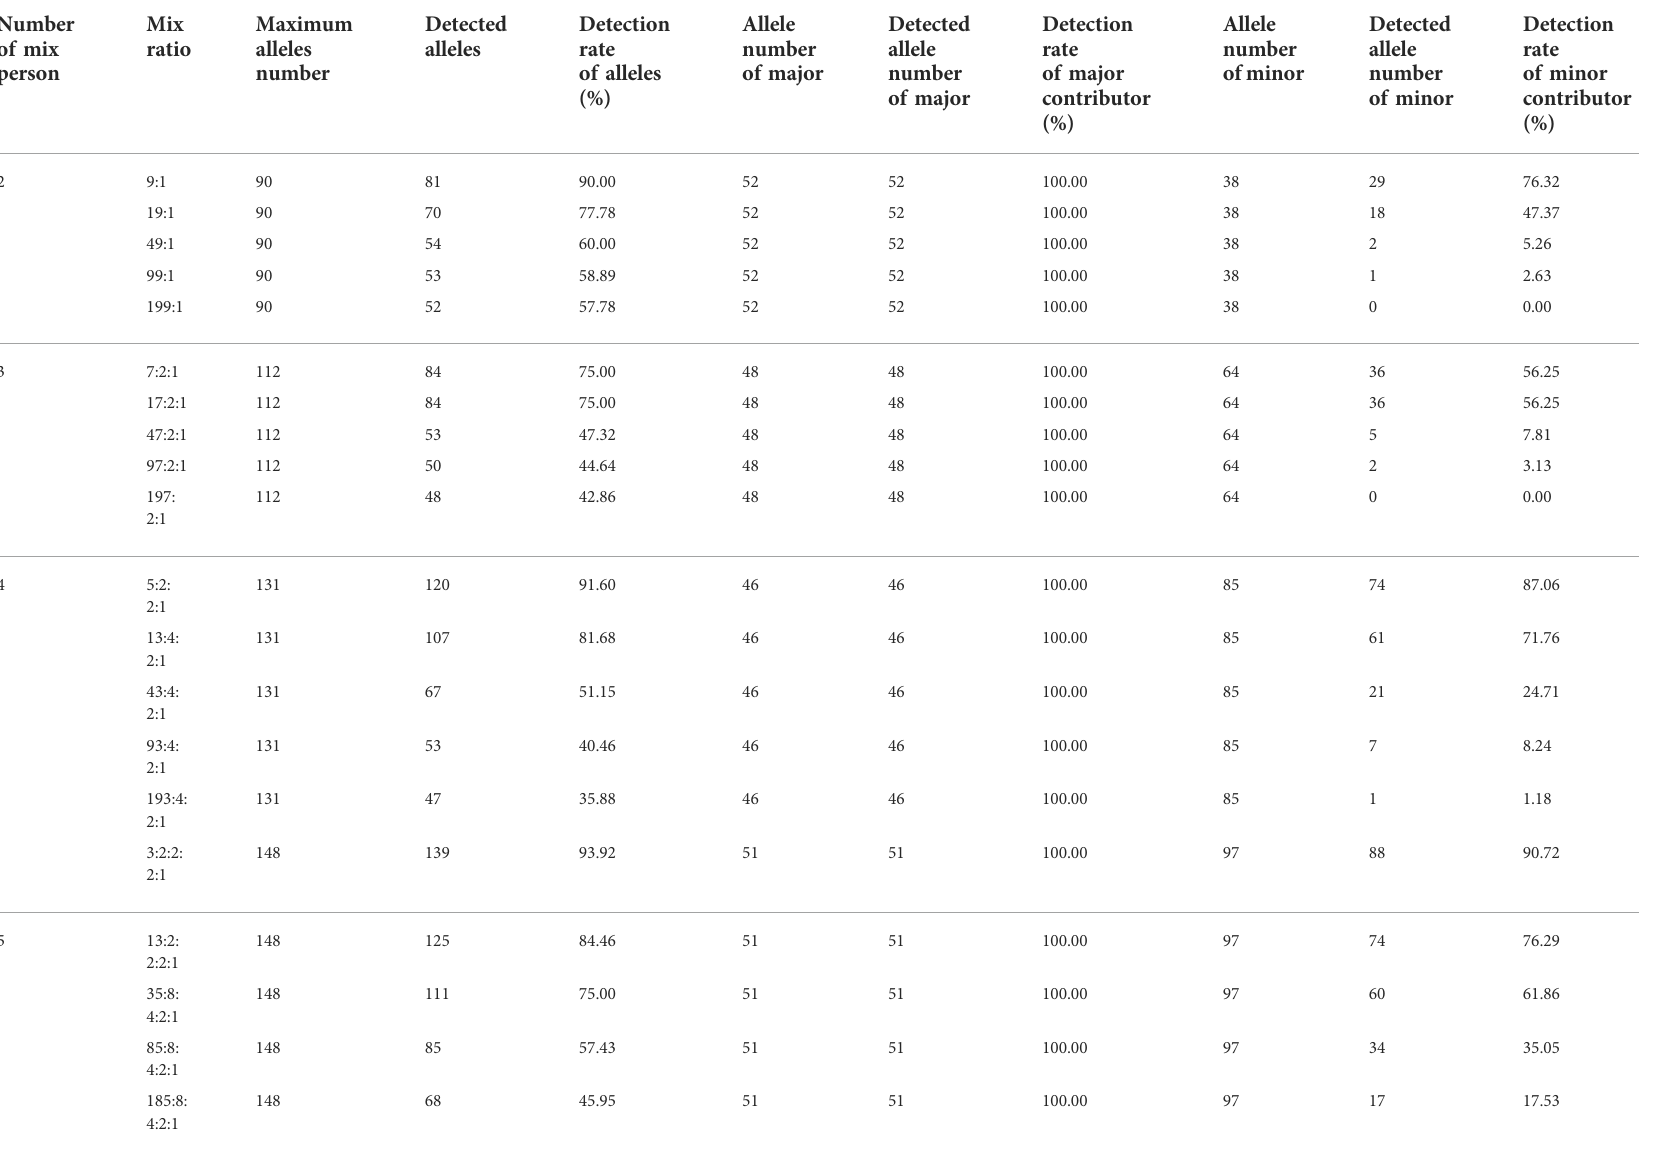
TABLE 2 NGS-STR analysis results of DNA mixtures. Number of